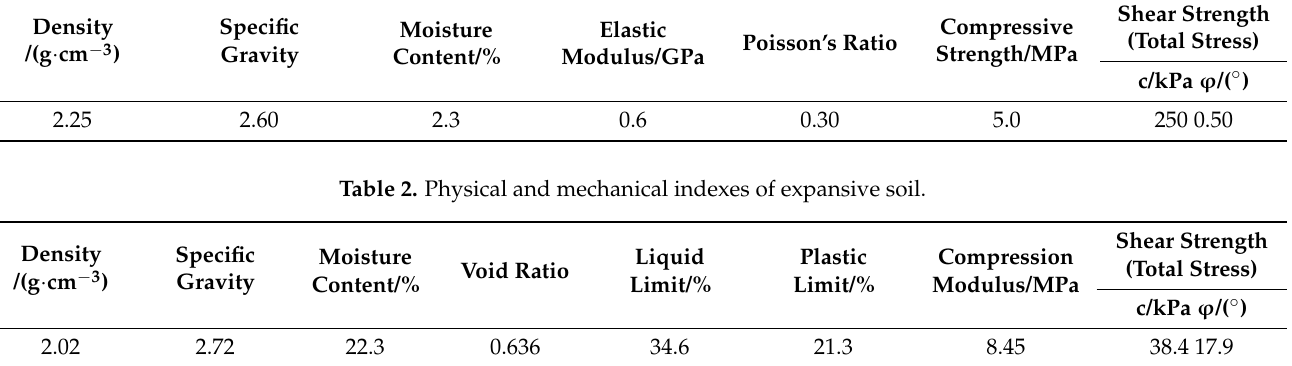
Figure 2. Stratigraphic profile of the testing bar. Table 1. Physical and mechanical properties of argillaceous sandstone.